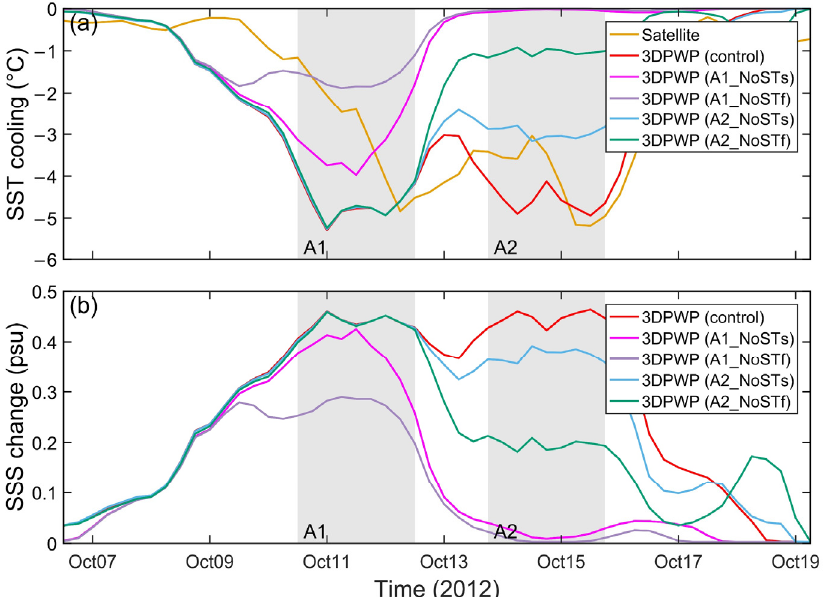
Figure 14. Temporal evolution of average SST cooling and SSS salinification averaged within 100 km of the typhoon centre in the 3DPWP experiments. ( a ) The evolution of SST cooling; and ( b ) the evolution of SSS salinification. The grey shaded areas indicate the A1-ST and A2-ST stages. Table 2. Maximum SST cooling, maximum SSS salinification averaged within 100 km of the typhoon centre, and contributions of sudden turning to SST cooling and SSS salinification in each 3DPWP experiment.